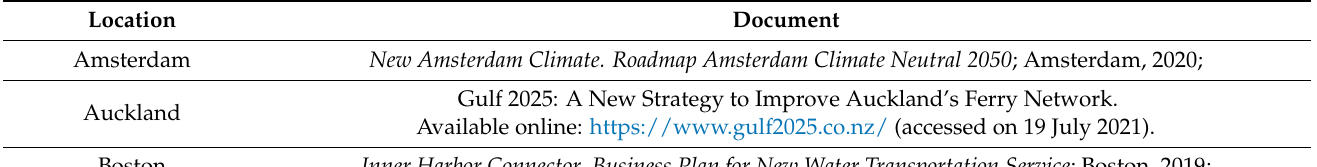
Table A2. The list of key strategic documents on ferry system